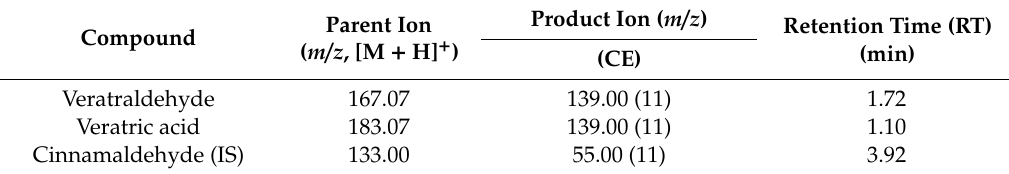
Figure 2. Collision-induced dissociation mass spectrum of veratraldehyde (1 µg/mL) ( a ), veratric acid (1 µg/mL) ( b ), and cinnamaldehyde (internal standard (IS) 10 µg/mL) ( c ) in positive ion electrospray ionization mode. Table 1. Optimized mass spectrometric conditions. CE, collision energy.